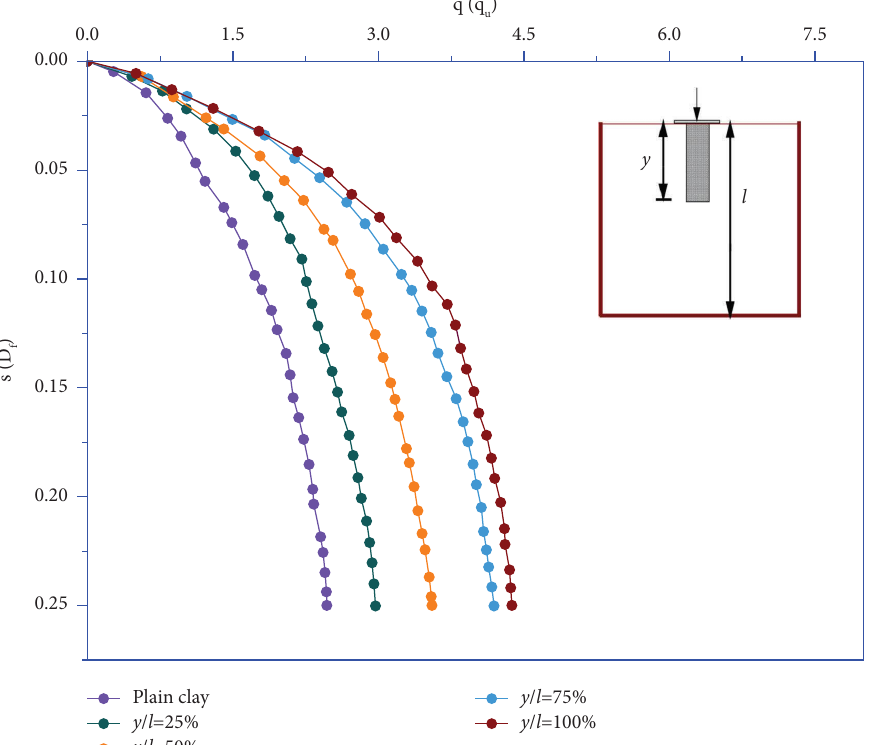
Figure 12: q / q u versus S / D f (ratio of settlement and footing diameter, D f ) curve for diferent lengths of cinder gravel